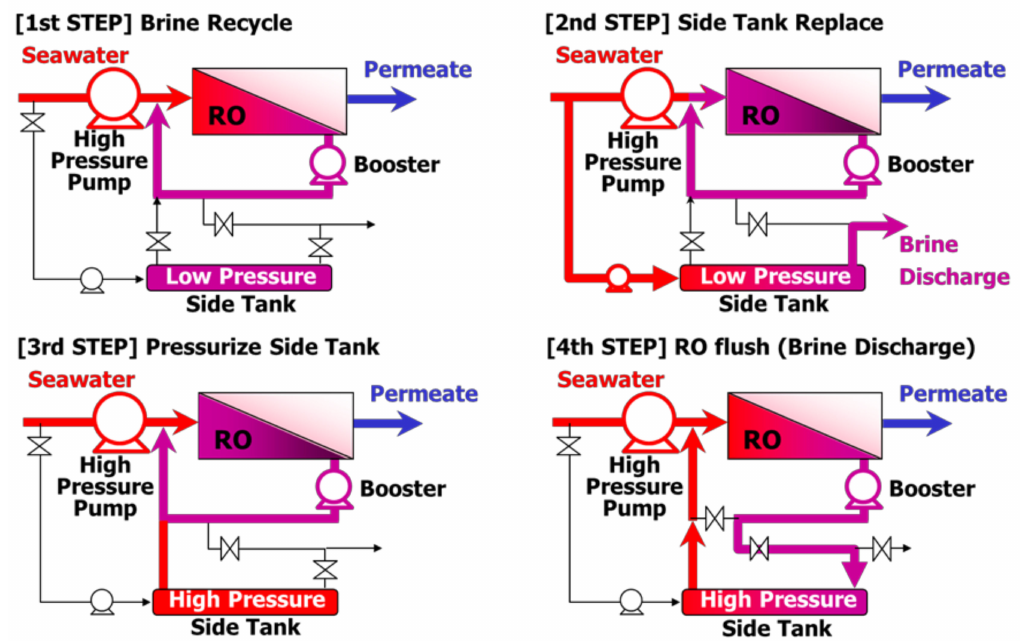
Figure 9. The sequential operation of CCD. At the first step, RO treatment is carried out with brine recirculation to feed water. The concentration of RO feed water gradually increases, then the brine stored in the side tank is discharged by pushing new seawater (second step). Then, the side tank is connected with the recirculation line to increase the pressure in the side tank (third step). Finally, the line is switched to push the seawater stored in the side tank to use feed water by replacing the condensed brine in the side tank (4th step), going back to the first